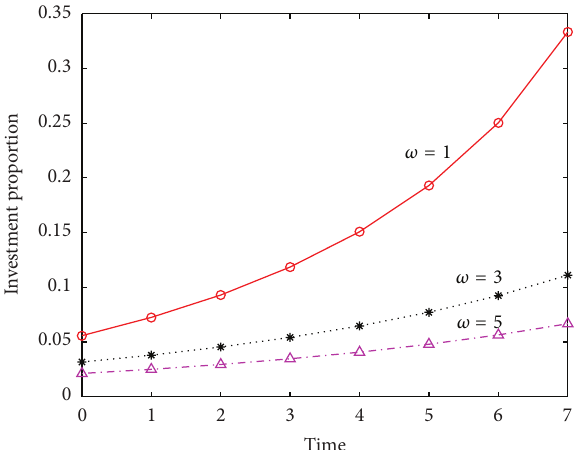
Figure 4: Effect of coefficient of risk aversion on the investment